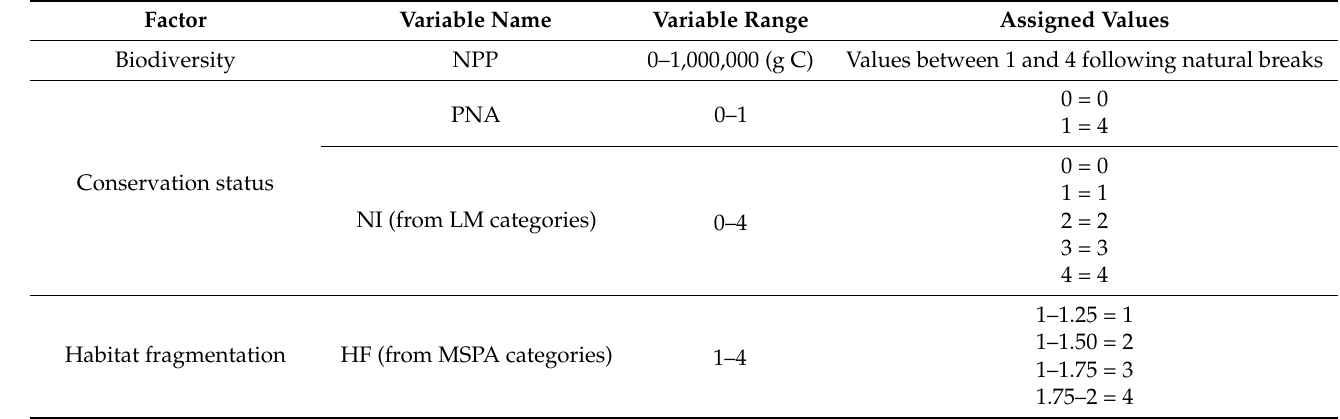
Table 4. Criteria to obtain categories for ecological values. NPP means net primary production, PNA is the acronym of protected natural areas, NI means natural index, LM is landscape mosaic, HF is the abbreviation of habitat fragmentation, MSPA is the abbreviation of morphological spatial pattern